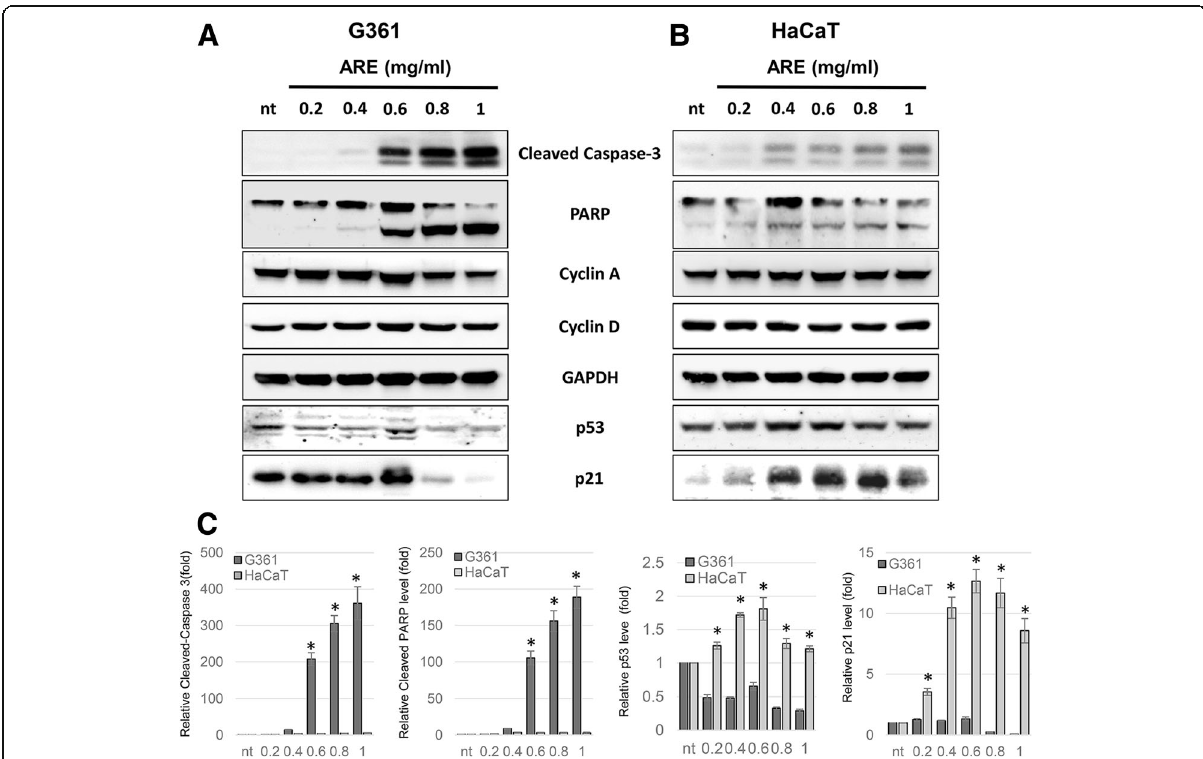
Fig. 3 Dose-dependent effects of ARE on the expression of apoptosis- and cell cycle-related proteins in G361 and HaCaT cells. The results of western blot analysis in G361 ( a ) and HaCaT ( b ) cells treated with 0.2, 0.4, 0.6, 0.8, and 1 mg/ml of ARE for 24 h are shown. GAPDH was used as a loading control. c The relative density of each protein of (A) and (B). Data represent the mean ± SEM ( n = 3). The significant difference between HaCaT and G361 cells were marked as * ( p <